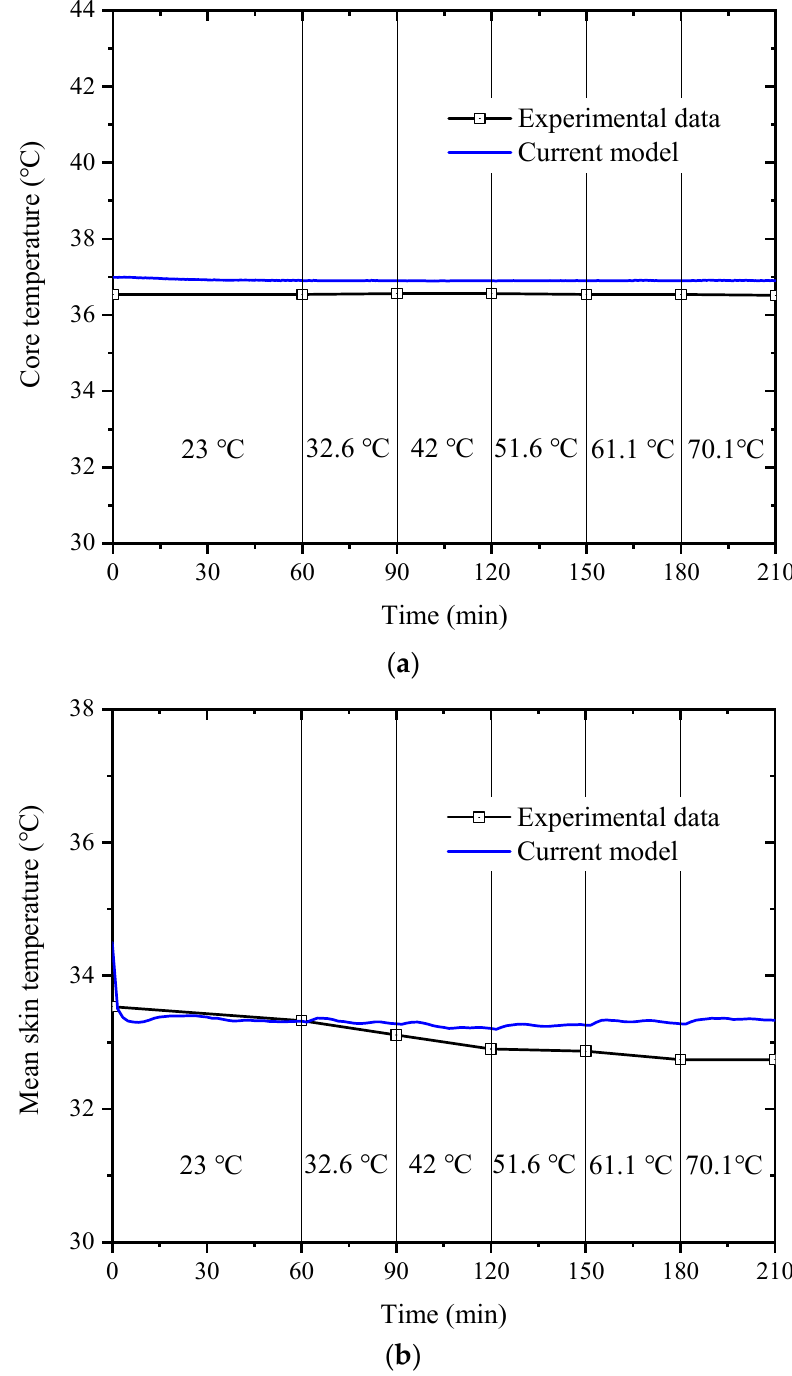
Figure 4. Comparison of core temperature ( a ) and mean skin temperature ( b ) between the experimental data [38] and the simulated results calculated with the current model.